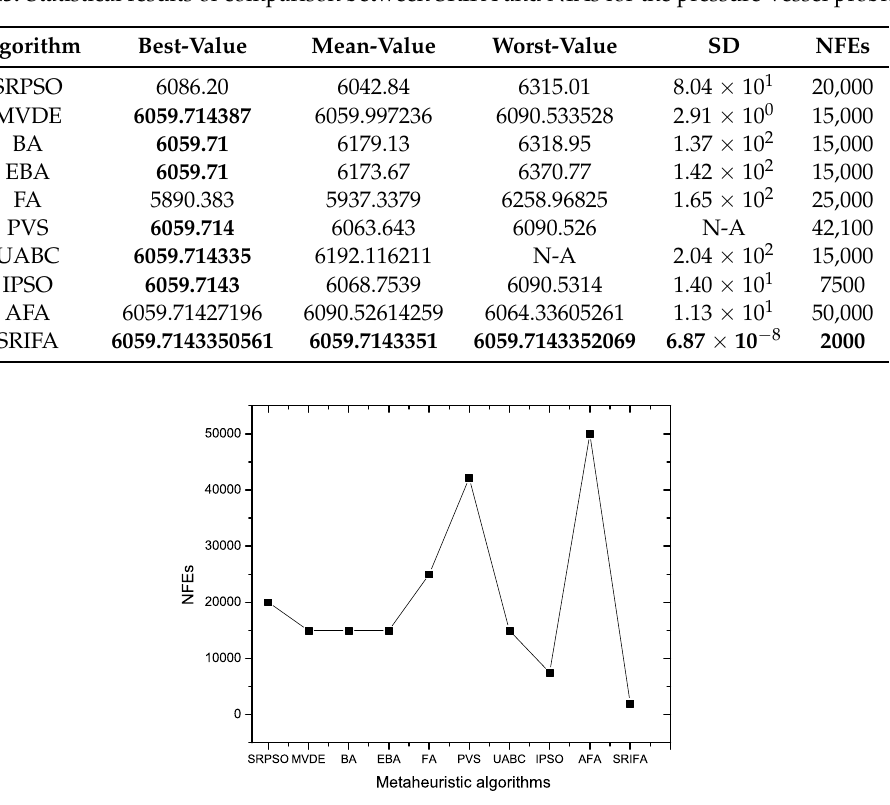
Table 13. Statistical results of comparison between SRIFA and NIAs for the pressure-vessel problem.